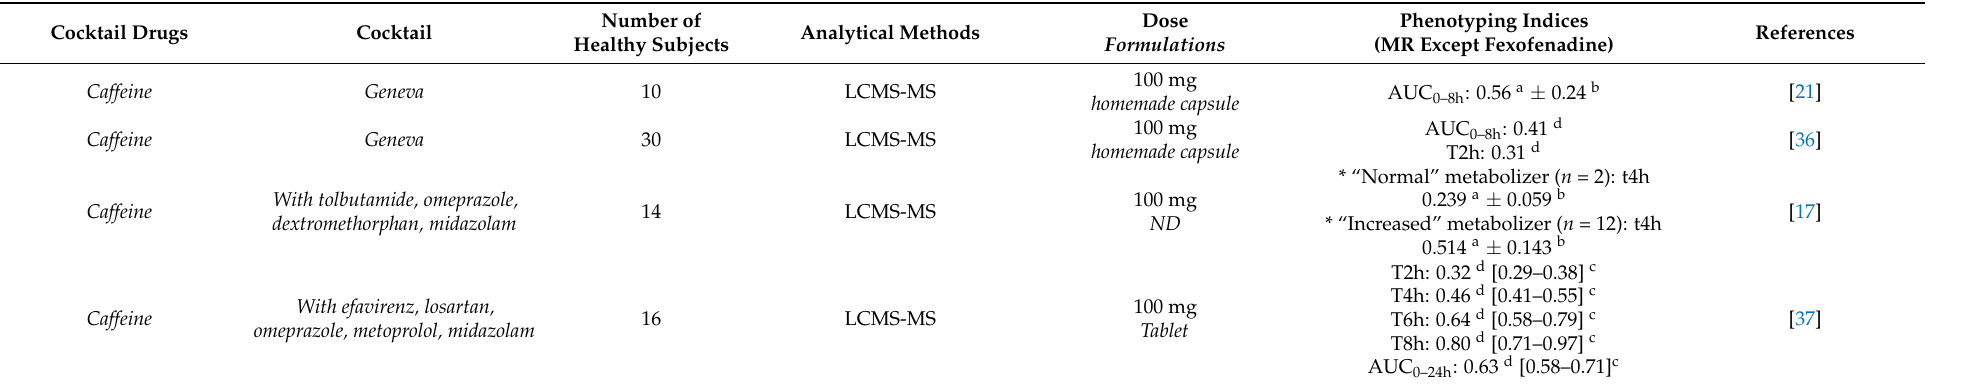
Table A5. Literature review of cocktail drugs and their phenotyping indices in healthy